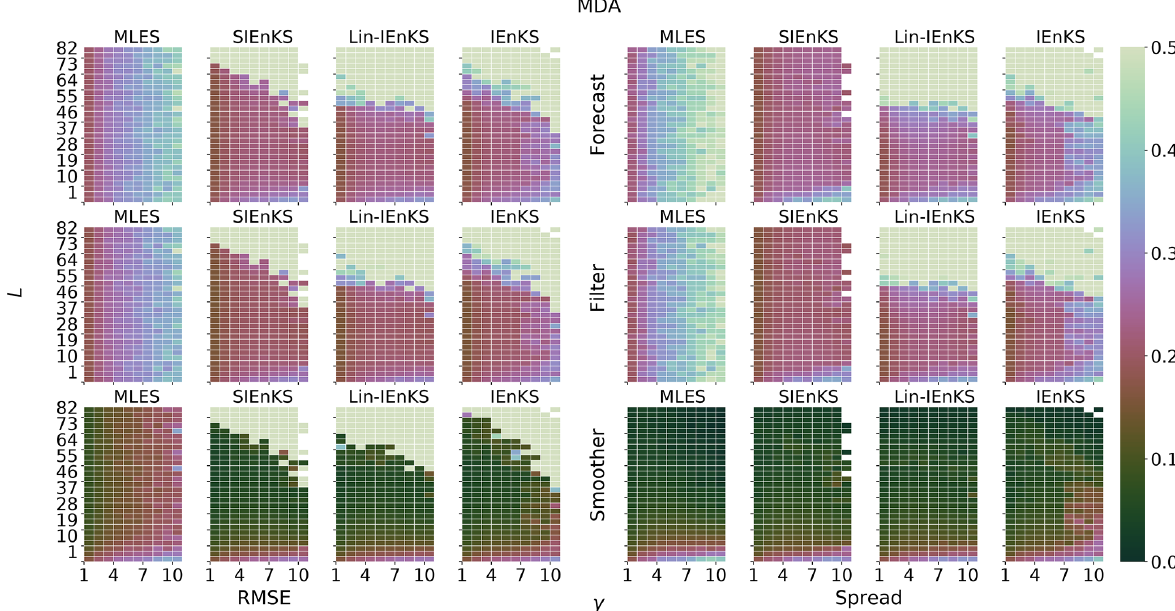
Figure 16. Lag length L is shown on the vertical axis, and the nonlinearity parameter γ is shown on the horizontal axis. MDA, tuned inflation, shift S = 1, N e = 21, and (cid:49)t = 0 . 05 are indicated. The MLES SDA results are presented here for